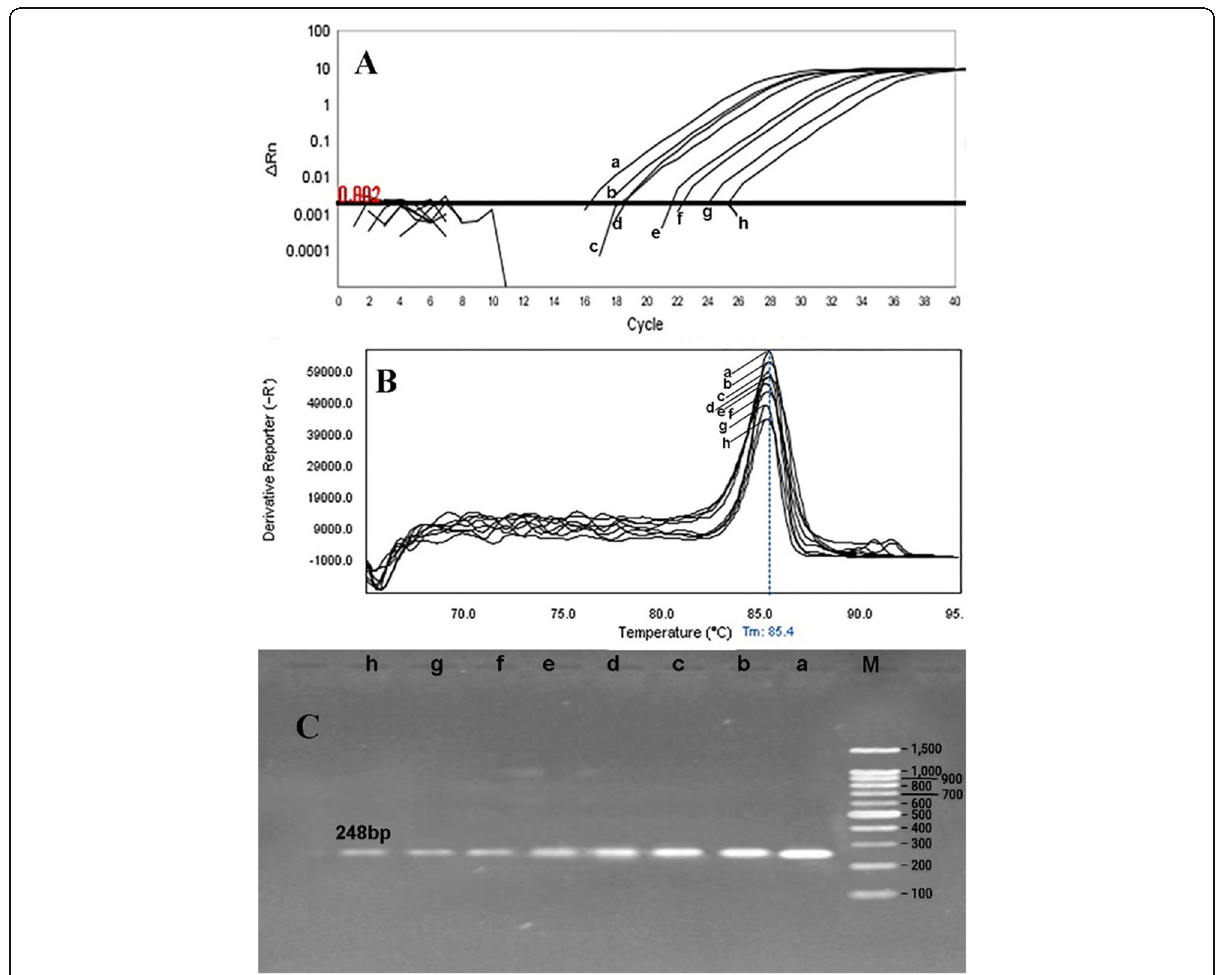
Fig. 2 Sensitivity of real-time PCR for primers used to detect of E. faecium ( alanine racemase gene) with a melting point of 85.4 ± 0.5 °C and amplification curve. E. faecium NCTC7174 (as standard bacteria) with the concentration of 0.5 McFarland (1.5 × 10 8 CFU/ml) was provided into serial dilutions of 10 7 to 10 0 CFU/ml. a 10 7 , b 10 6 , c 10 5 , d 10 4 , e 10 3 , f 10 2 , g 10 1 , and h 10 0 . a Amplification curve b Melting curve profile, and c corresponding agarose gel (1.5%) electrophoresis for real-time PCR amplification of alanine racemase gene. Horizontal lines represent cycle threshold of real-time PCR. One peak with a shoulder corresponds to genomic DNA amplification; no peak corresponds to no amplification. SYBR Green I color and single-tube reaction were used in this test. Also, real-time PCR was performed as single